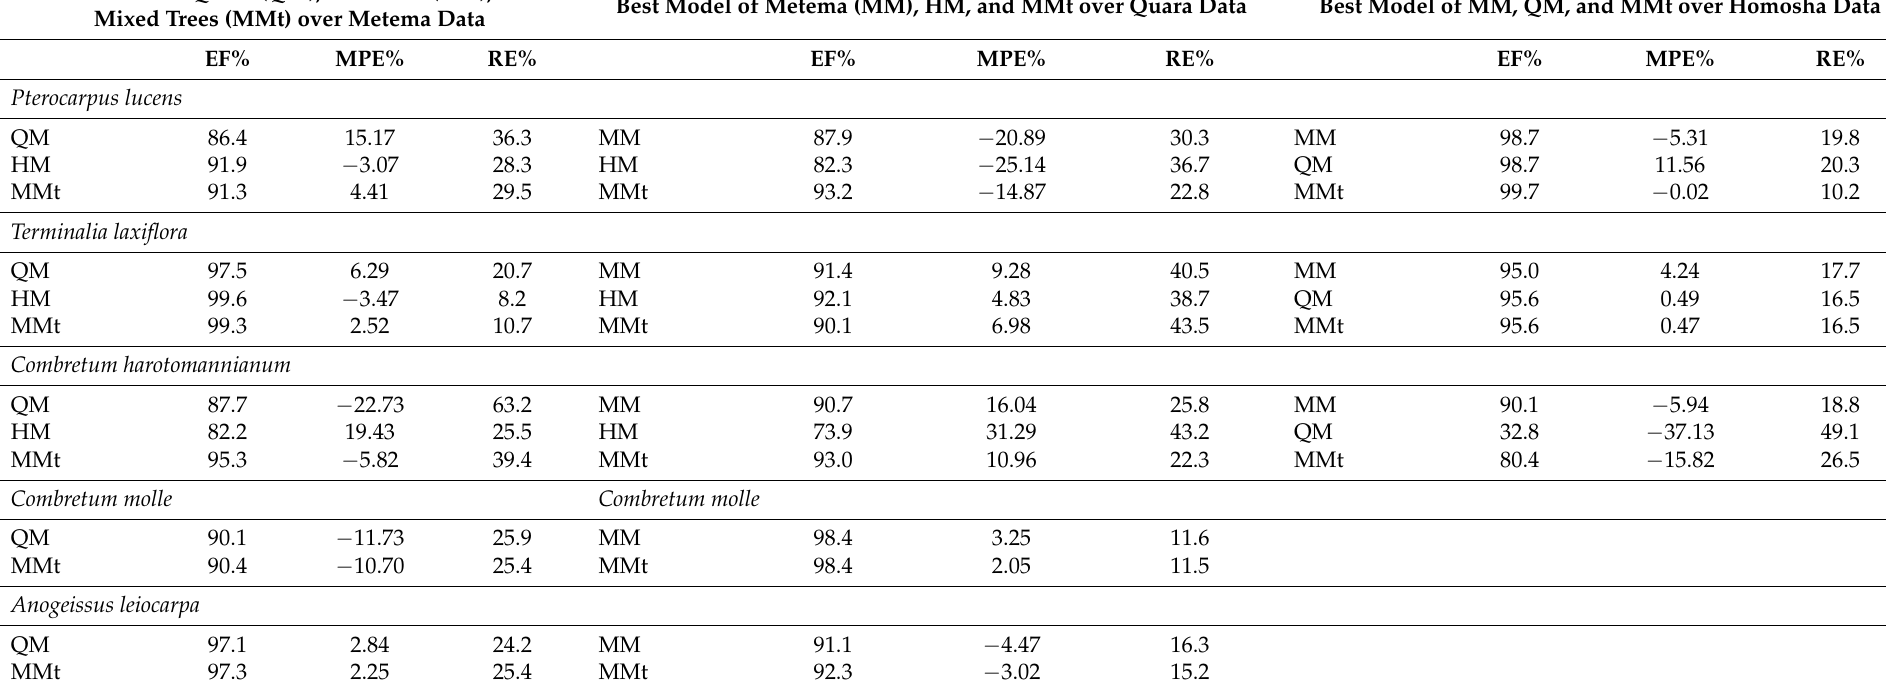
Table A5. Validation of species-specific models and fit statistics that show the effect of site variation on the accuracy of aboveground